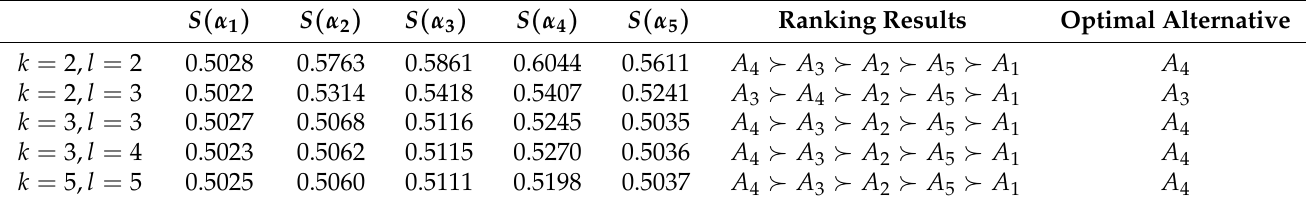
Table 6. Ranking results of the TSFWIGBM